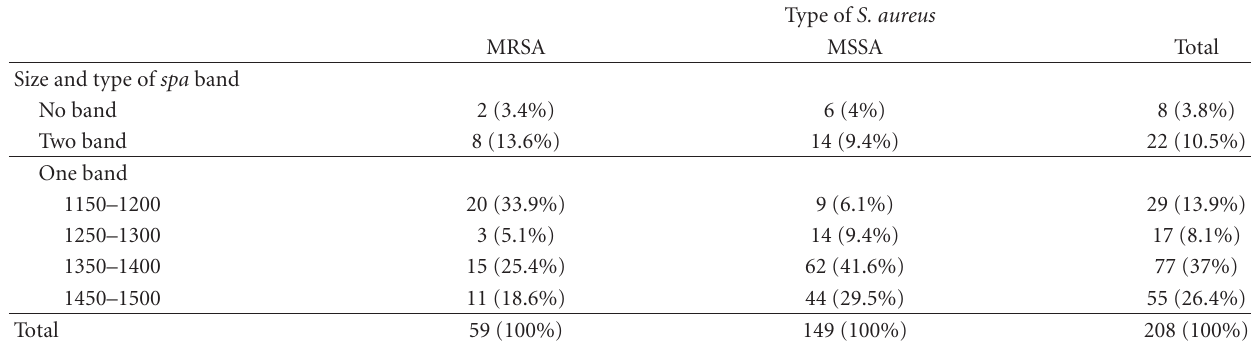
Table 3: Distribution of spa gene in MRSA and MSSA isolates in Gorgan, north of Iran.